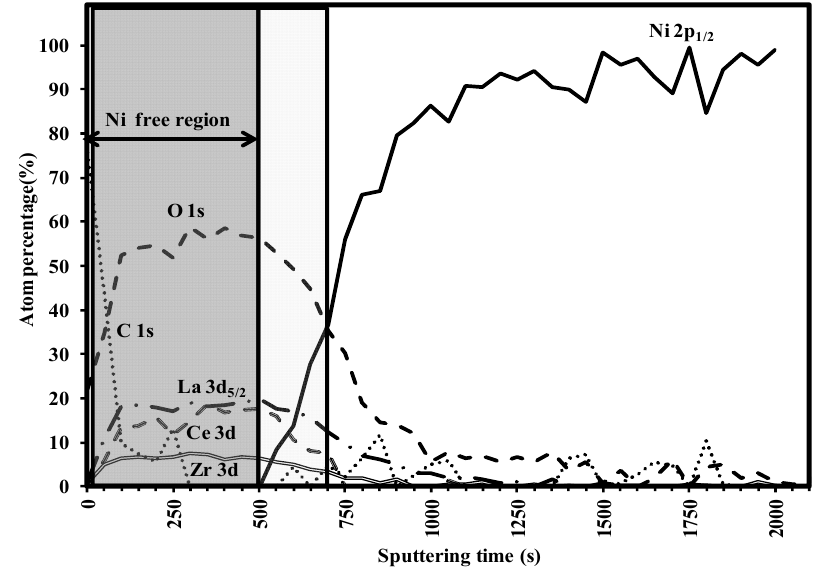
Figure 6. XPS overview spectrum of the various elements through the La